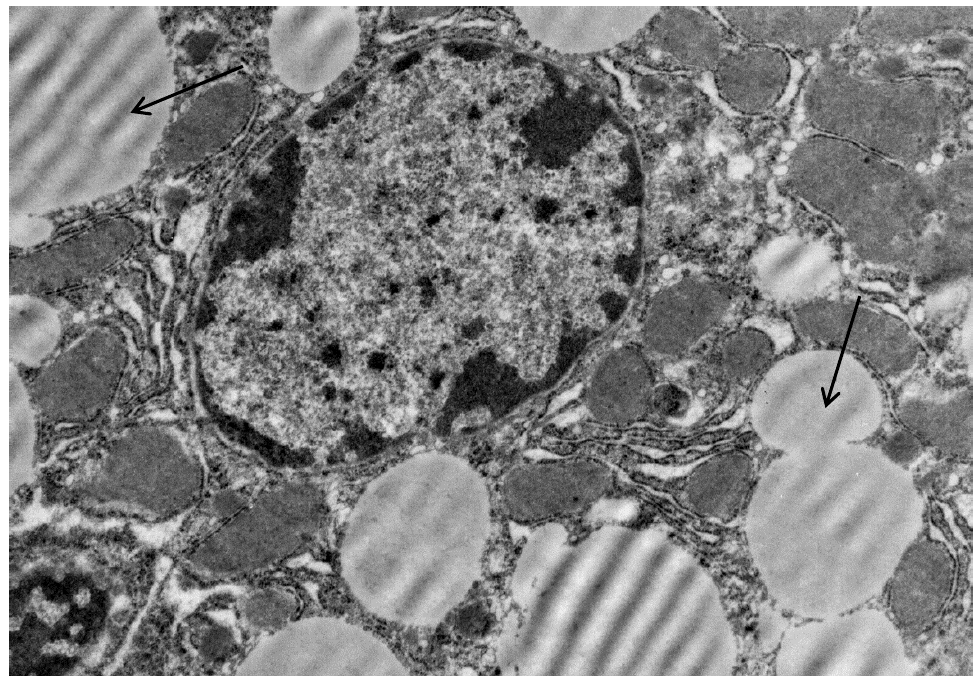
Figure 3. Liver cells of mice with acute lipemia induced by P-407 (250 mg/kg, 24 h). Fragment of hepatocyte of mice, 24 h after P-407 administration. The accumulation of lipid droplets (arrows). Magnification 6000×.